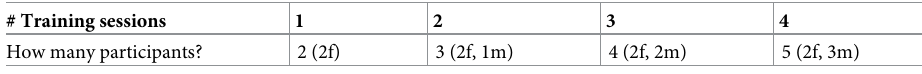
Main sessions. Analysis 3 : Compering the VR systems during the main sessions , for MSAQ scores . Kruskal-Wallis test was used for P and G (see Tables 4 and 6) that returned an exact sig- nificance of 0.388. Therefore, there is no meaningful difference between different VR systems during the main experiments (stabilized motion sickness).